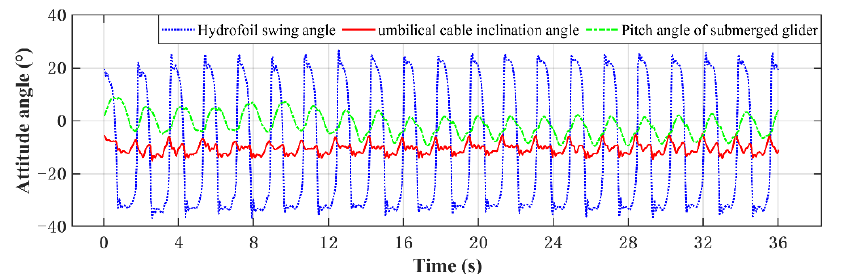
Figure 24. The attitude angle comparative experiment of the SALL submerged glider.